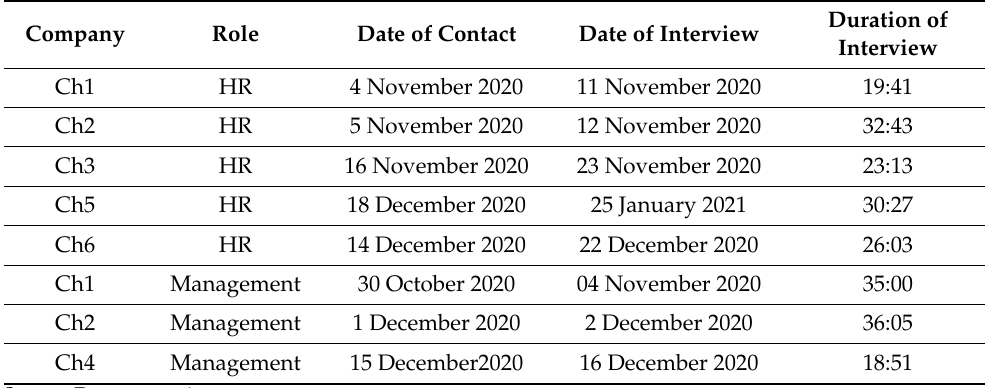
Table 2. Age and years of working experience (WorkExp) of participants in the research. Average age of participants Average years of WorkExp of participants Average years of WorkExp of HR participants Average years of WorkExp of management